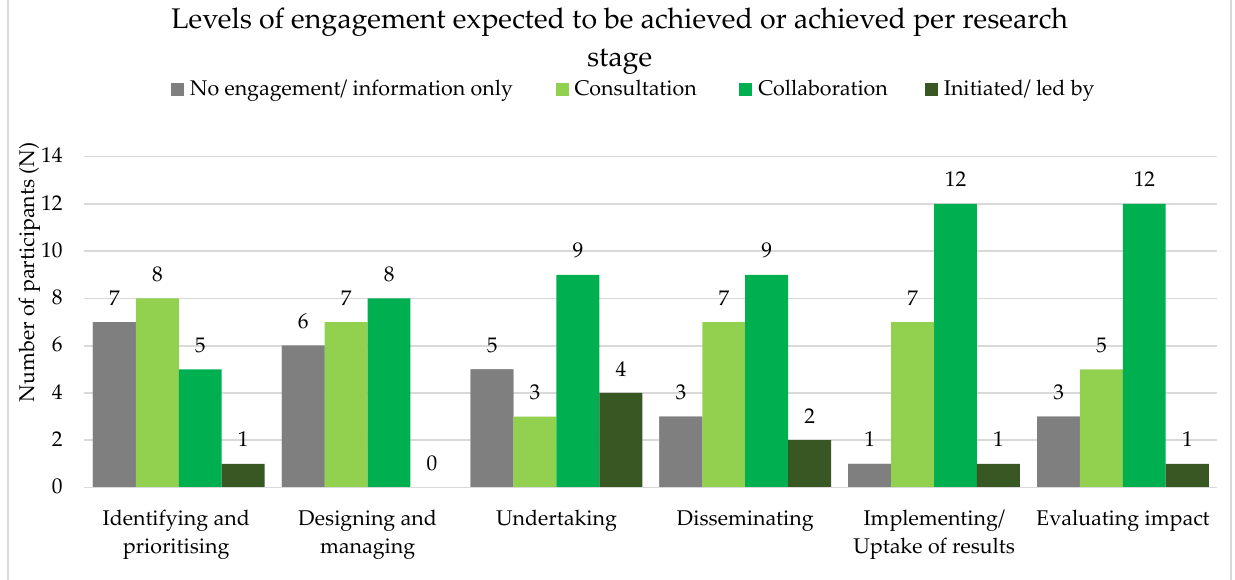
Figure 3. Levels of engagement achieved or expected to achieve, indicated per research stage.